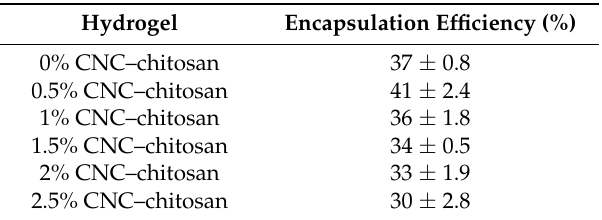
Table 1. Encapsulation efficiency of curcumin for different hydrogels.